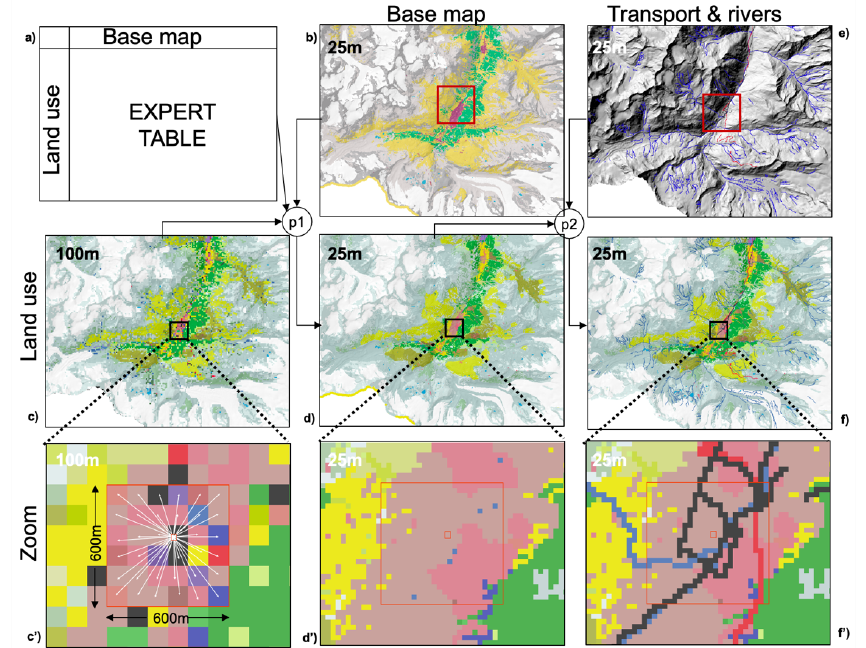
Figure 3. Downscaling land use statistics (2013–2018) in the area of Zermatt from 100 m to 25 m resolution using inverse distance weighting, expert knowledge, national base map, transport and river information at 25 m. ( a ) Expert system (details in Figure 4), ( b ) 1:25,000 base map, ( c , c’ ) hectare land use information, ( d , d’ ) downscaled land use, ( e ) 1:25,000 linear features (rivers, roads and rails), ( f , f’ ) overlay of linear features to downscaled land use at 25 m resolution. Downscaling process (p1) and linear features addition (p2).